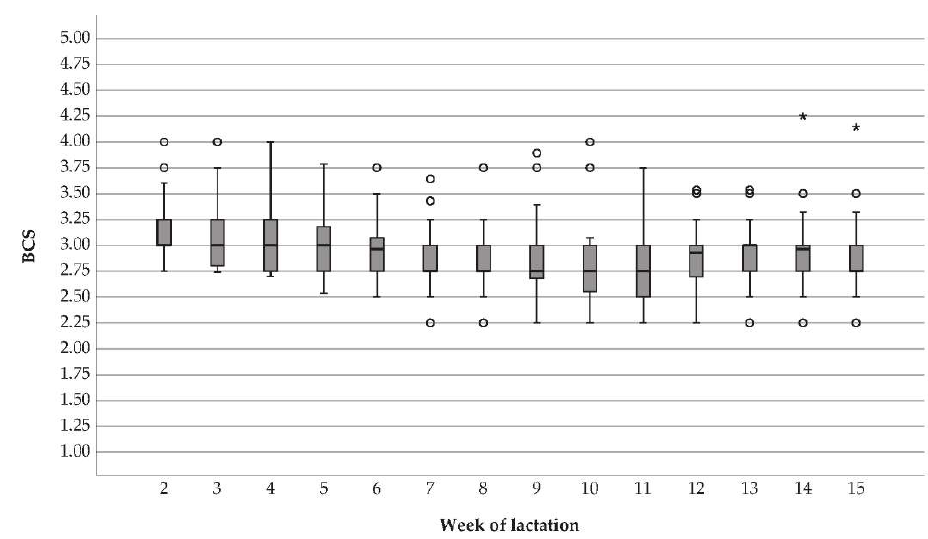
Figure 3. BCS data of dairy cows ( n = 28) between weeks 2 and 15 postpartum (p.p.). In each subfigure, the boxplots respectively highlight the median, upper, and lower quartiles of each week. Box whiskers extended to the most extreme nonoutlier data points were considered as outliers if they lay more than 1.5 times the interquartile range from the edge of the box. Small circles = outliers (1.5 × interquartile range (IQR)); asterisks = extreme values (3 × IQR). BCS changes between two weeks are shown in Figure 4.